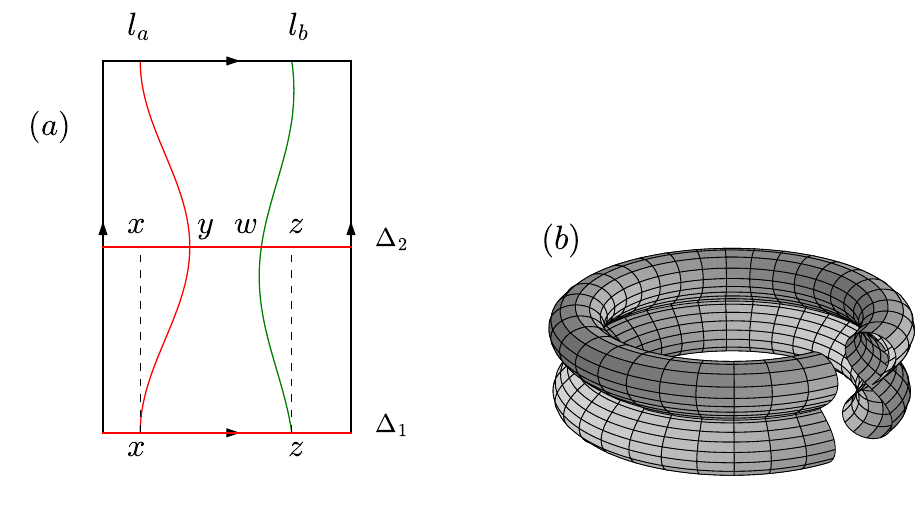
Figure 5: A surface with the topology of a torus, with the identification of ∆ ∆ and the edges (a), which is a double cover of the torus over a parallel ∆ 2 arbitrary closed loops l in (b), with its self-intersection curve ∆ , with preimages ∆